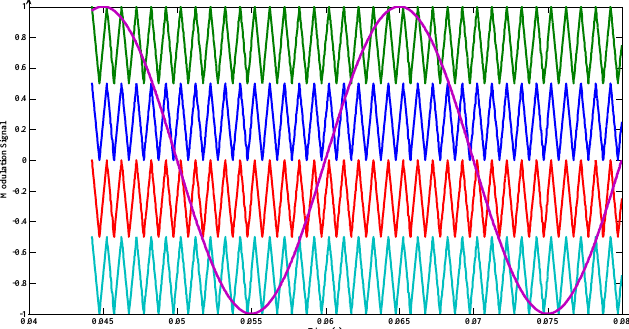
Figure 36. Waveform for phase opposition method.